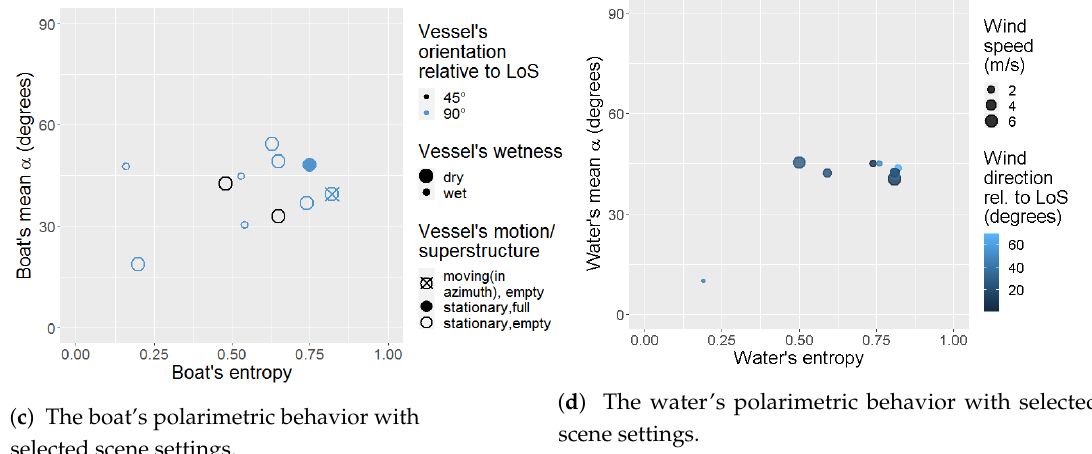
Figure 18. A comparison of the inflatable’s and the water surface’s entropy and mean α with sensor settings and scene settings for co-polarized